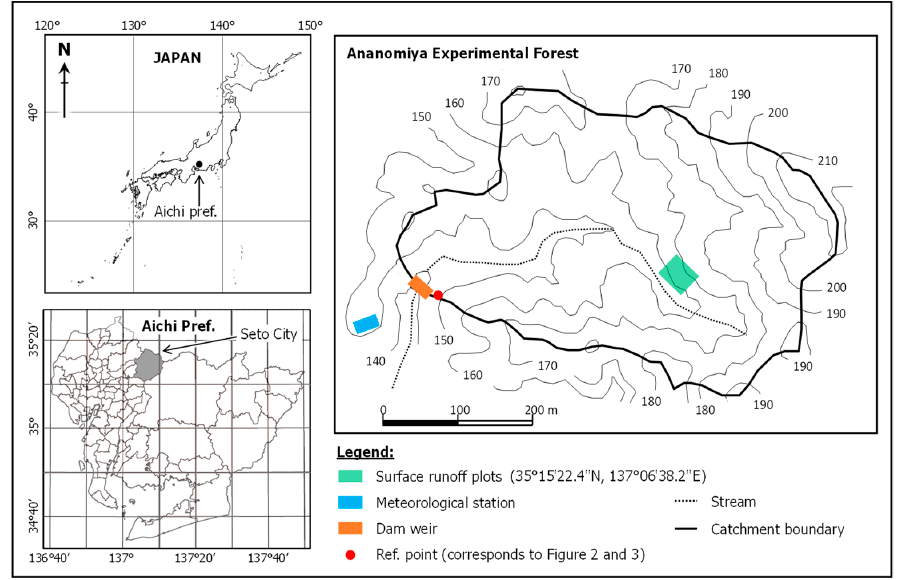
Figure 1. Study area. Map of Japan and Aichi prefecture were drawn via the software R v.4.0.3 using packages “maps”, “mapdata”, and “mapproj”. Map of AEF and contours were obtained from the archives of the Ecohydrology Research Institute